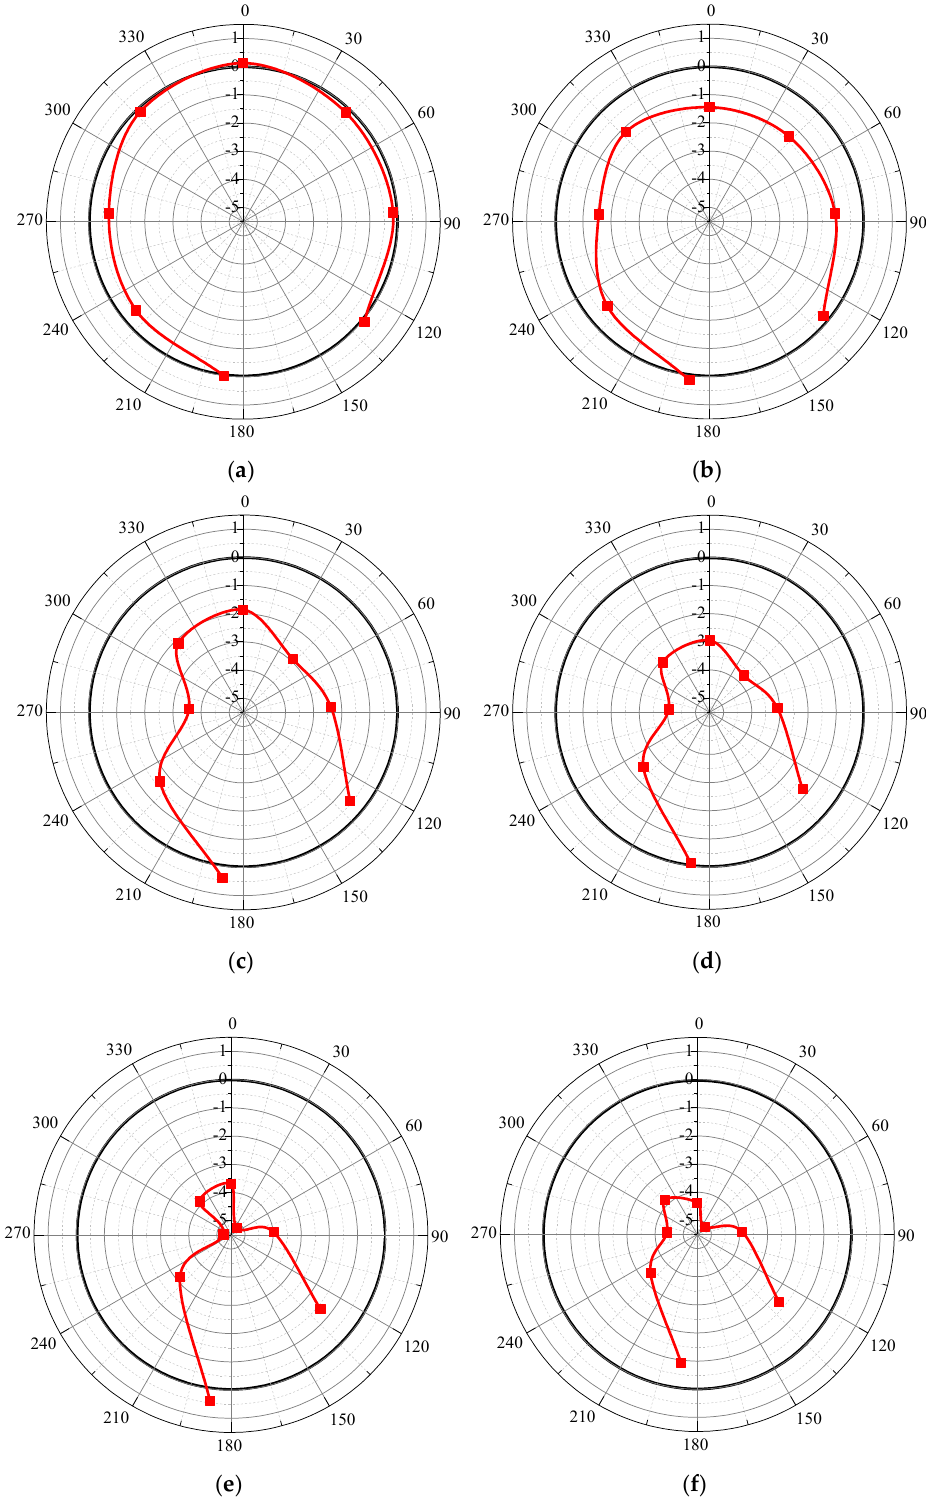
Figure 11. Induced hoop stress of the existing tunnel in the transverse section. ( a ) Far-field excavation; ( b ) Forepoling reinforcement; ( c ) Right line underpass construction; ( d ) Deep hole grouting in the left line and post-wall grouting in the right line; ( e ) Left line under crossing construction; ( f ) Grouting and stabilization behind the left line wall.